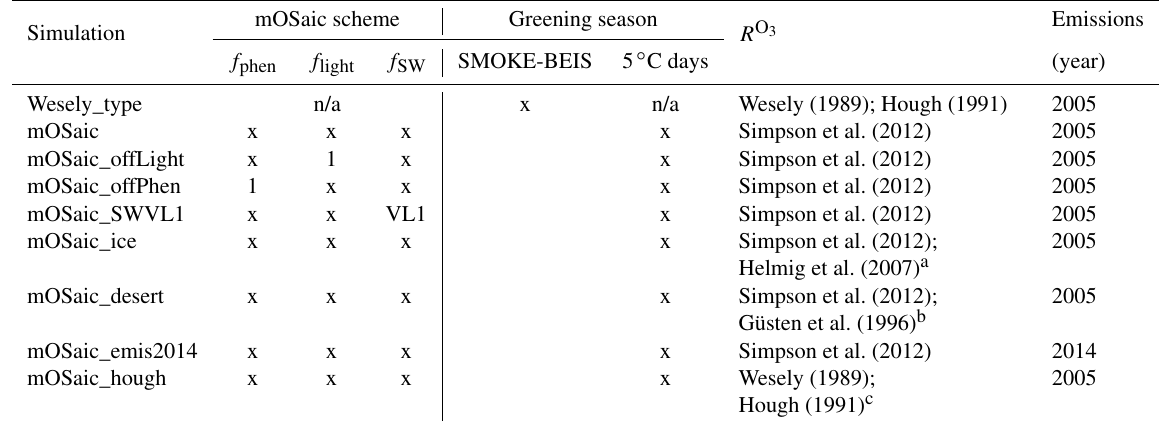
Table 2. Summary of specifications of all simulations discussed in this section. For simplicity, only the tested parameters are listed. An “x” denotes that the model was run exactly in the configuration as has been described in Sect. 2. Here, “n/a” means that these parameters are not applicable in this experiment for it has been conducted with Wesely scheme.